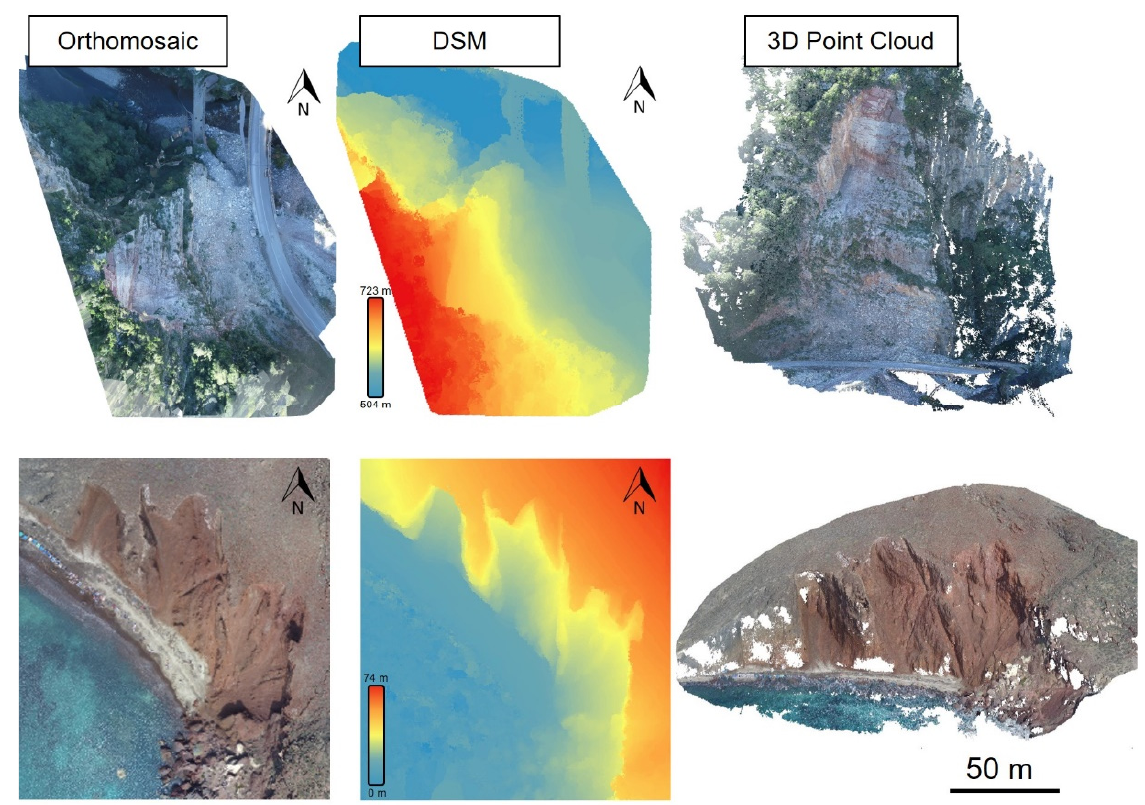
Figure 4. The digital models (upper: Proussos case, lower: Red Beach case) generated by SfM photogrammetry and used as inputs to the developed segmentation pipeline. From left to right, the columns depict: the orthomosaic, the DSM showing lower elevation in cooler colours and higher elevation in warmer colours, and 3D point cloud.